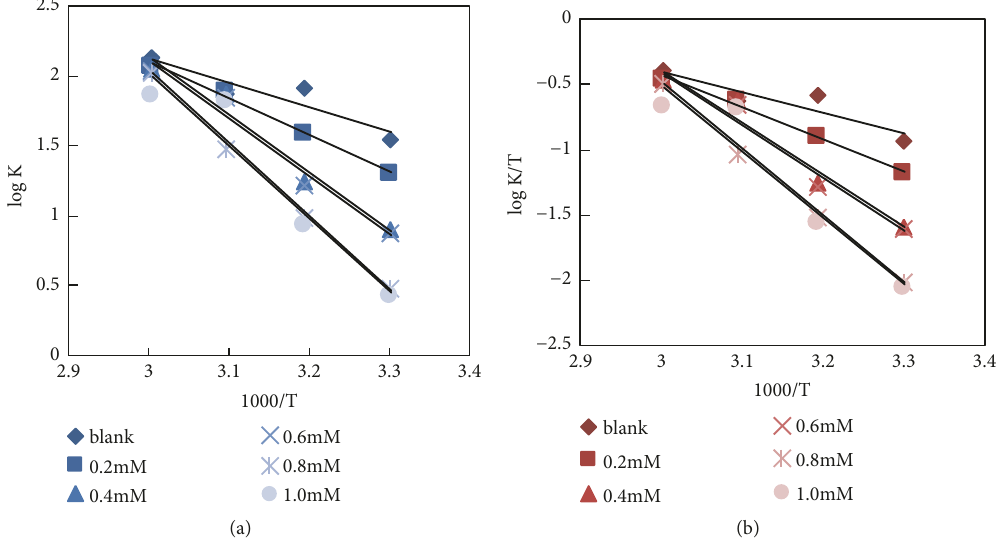
Figure 7: Plot of (a) log K versus 1000/T (b) log K / T versus 1000/T with and without DmChDp in 0.5M H 2 SO 4